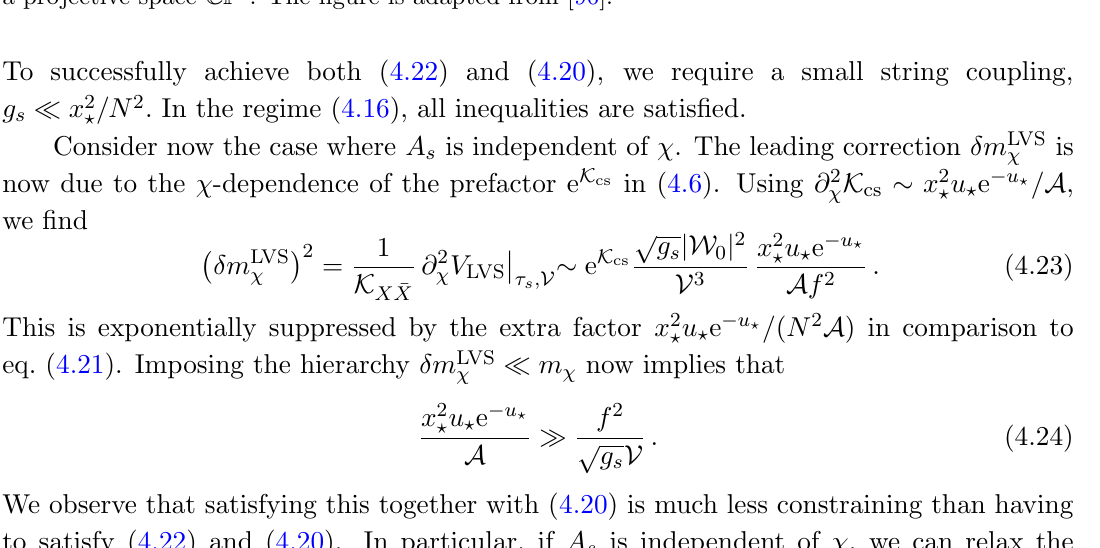
Figure 7 . The point-like singularity is resolved by the blow-up cycle (cid:28) s by replacing the point with a projective space CP 1 . The (cid:12)gure is adapted from